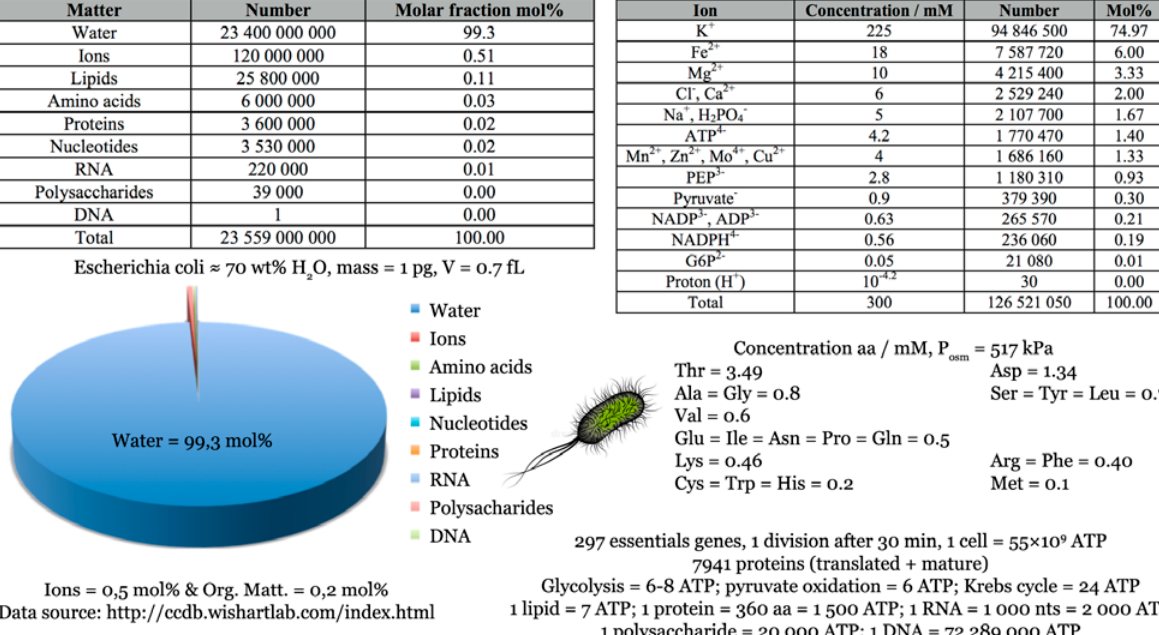
Figure 1. Molecular composition and basic energetic needs for the Gram-negative prokaryote Escherichia coli according to the CyberCell Database (CCDB).